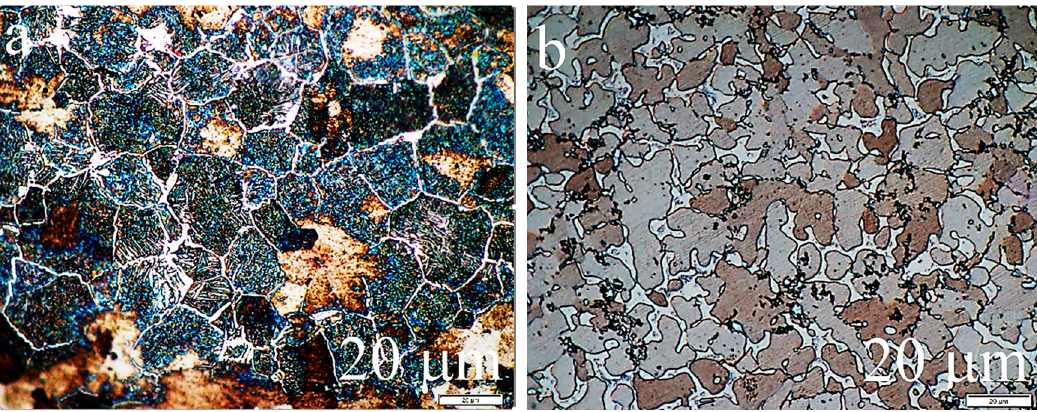
Figure 3. Microstructure of: ( a ) matrix material and ( b ) composite—etched surface, Nomarski contrast, optical microscope.